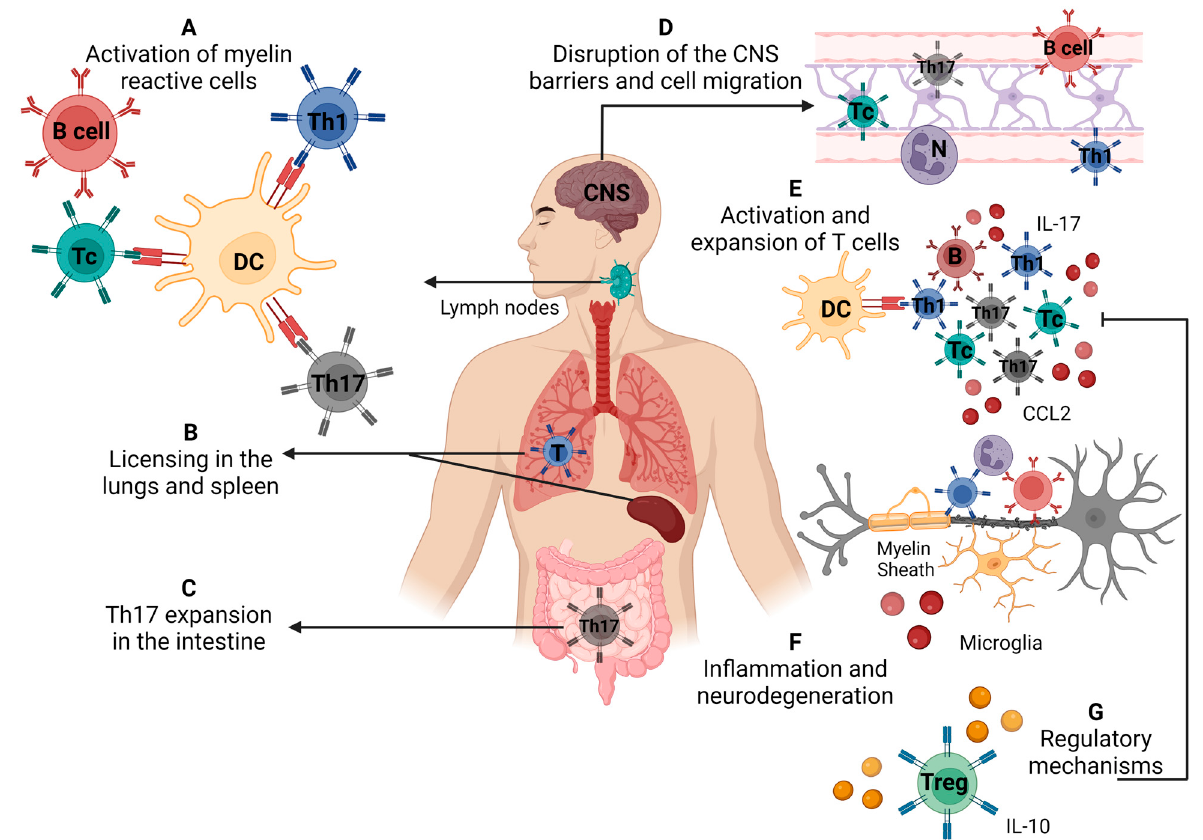
Figure 3. Immunopathogenesis of multiple sclerosis/experimental autoimmune encephalomyelitis. ( A ) Activation of self-reactive T cells specific for myelin antigens in secondary lymphoid organs, ( B ) licensing of self-reactive cells in the lungs and spleen ( C ), differentiation of Th17 cells in the intestine, ( D ) disruption of the blood–brain barrier and cell migration to the central nervous system, ( E ) local reactivation and expansion of Th cells, ( F ) local inflammatory process that leads to demyelination and neurodegeneration, ( G ) cells and molecules that mediate the control of disease via regulatory mechanisms. Source: Created with Biorender.com.